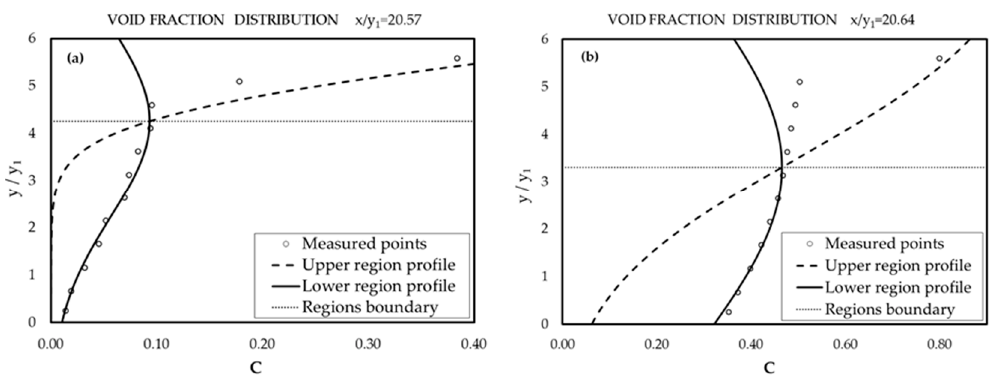
Figure 6. Measured void fraction in a vertical profile with the adjusted expressions for the upper and the lower regions: ( a ) Physical model ( x/y 1 = 20.57), ( b ) numerical model ( x/y 1 = 20.64).